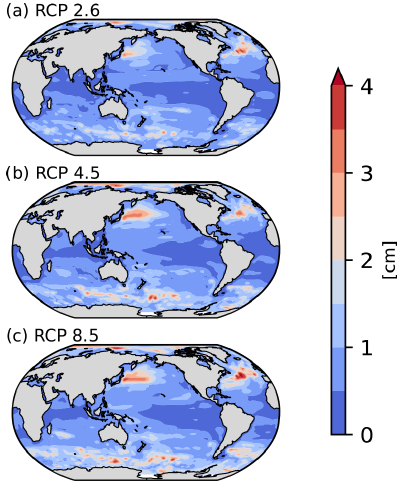
Figure 8. Maximum difference between DSL change in 2100 ob- tained by pattern scaling with coefficients fitted to unfiltered and LFCA-filtered realizations, considering all 100 MPI-GE members, for RCP2.6, RCP4.5, and RCP8.5 ( a , b , and c ,